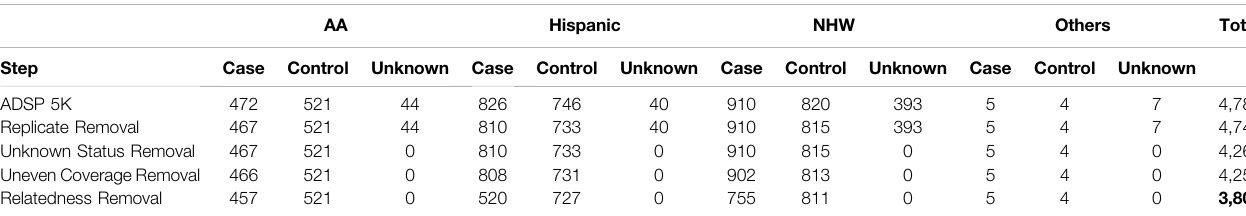
TABLE 1 | Total column denotes the number of samples remaining after each quality fi ltering step. AA Hispanic NHW